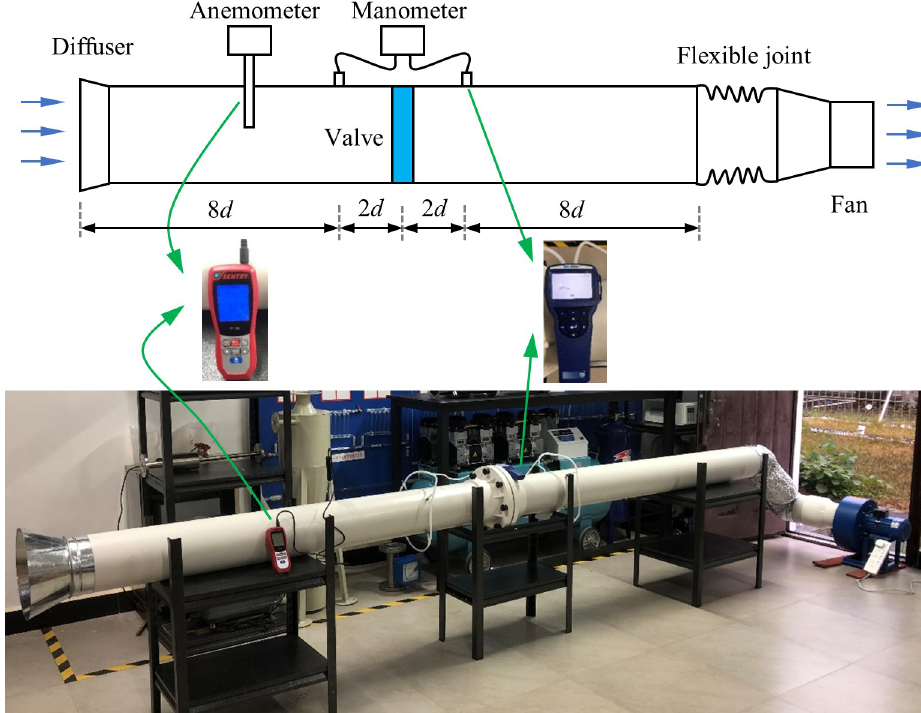
Fig 4. Schematic diagram of the experimental system.